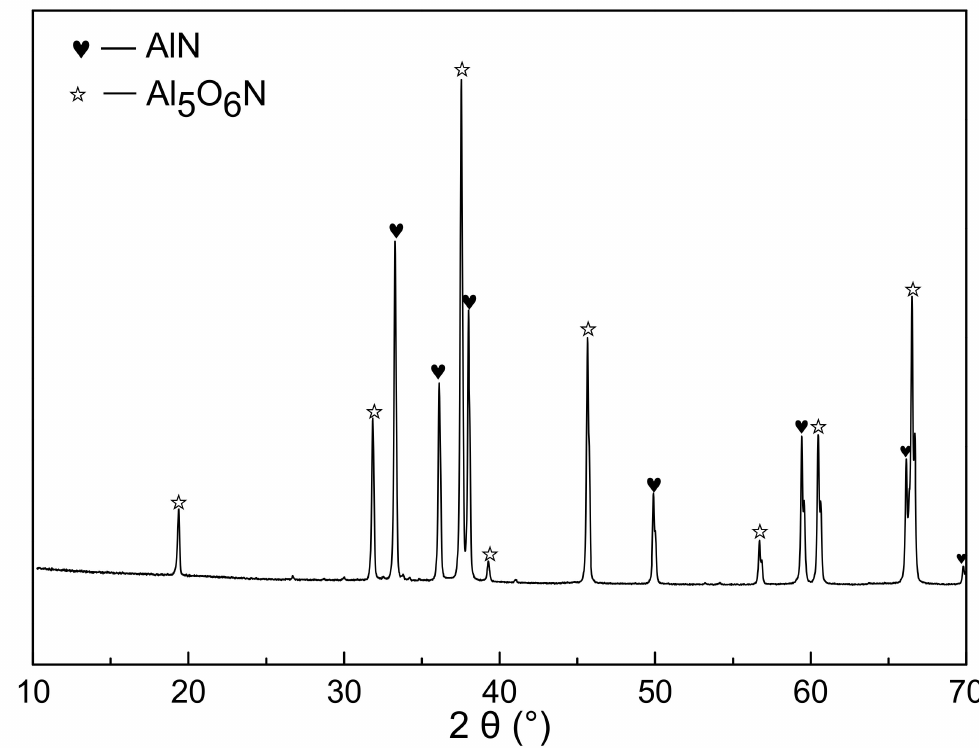
Figure 9. XRD patterns of fired powders with Al(OH) 3 and PVB (sample